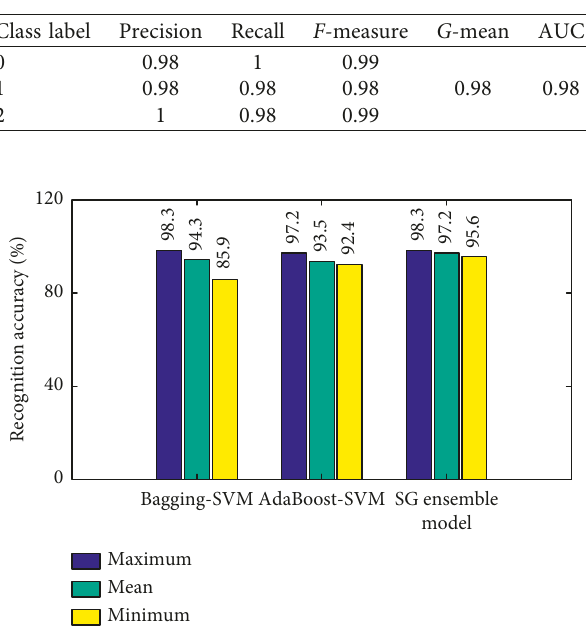
Figure 13: Confusion matrix of the SG ensemble model with overall classification accuracy 98.7%. Table 8: Performance evaluation results of the SG ensemble model.